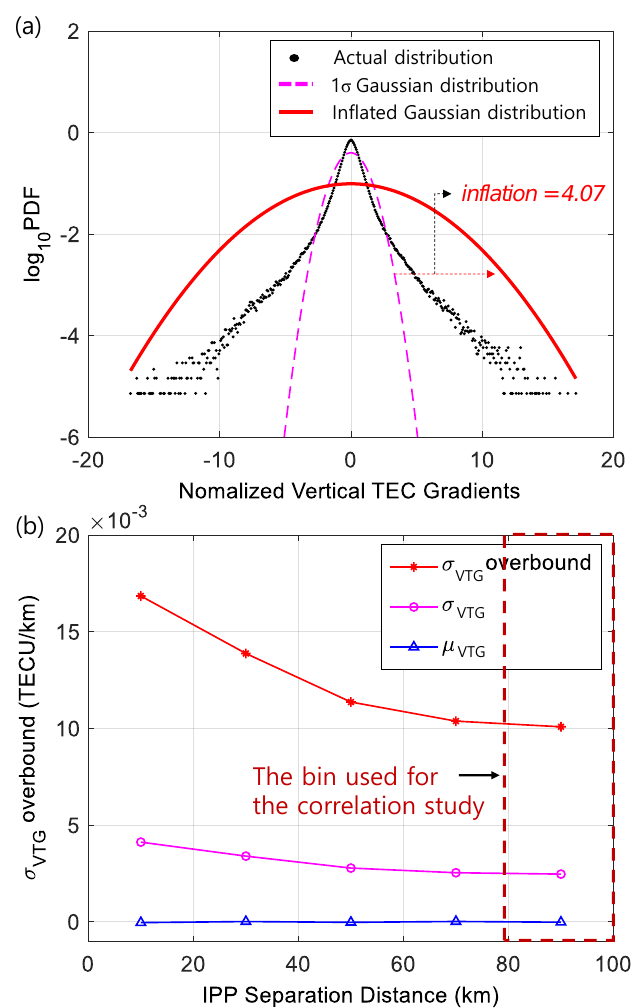
Figure 3. Results of Gaussian probability density function (pdf) overbounding using data of 26 July 2004. ( a ) Normalized vertical TEC gradient distribution with overbounded Gaussian distribution by applying an inflation factor, and ( b ) means, standard deviations, and overbounded standard deviations of vertical TEC gradients for each bin.